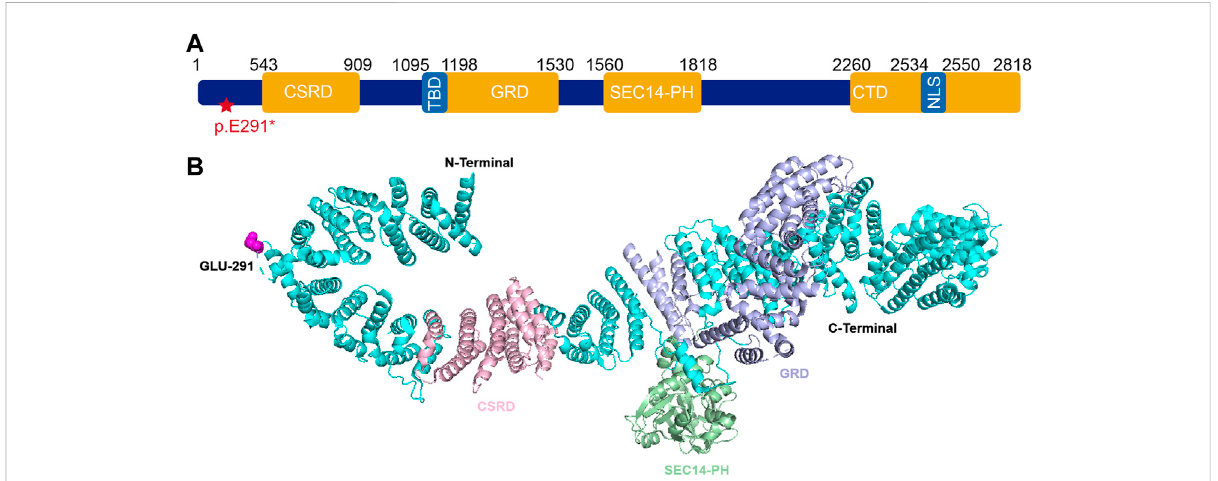
FIGURE 6 (A) Schematic representation of neuro fi bromin protein and identi fi ed mutation of NF1 (c.871G > T; p. E291*) in this study. (B) The 3D structure of neuro fi bromin1 monomer. The NF1 was represented in cartoon and the mutation site (p.E291*) was shown as magenta sphere. The CSRD domain (residues 543 – 909) (light pink), GRD domain (residues 1095 – 1530) (light blue), SEC14-PH domain (residues 1560 – 1818) (pale green). Abbreviations usedare as follows CSRD, cysteine-serine-rich domain; GRD, GAP-related domain; TBD, tubulin-binding domain; SEC14-PH, Sec14- homologous domain and pleckstrin homology domain; CTD, C-terminal domain; NLS, nuclear localization